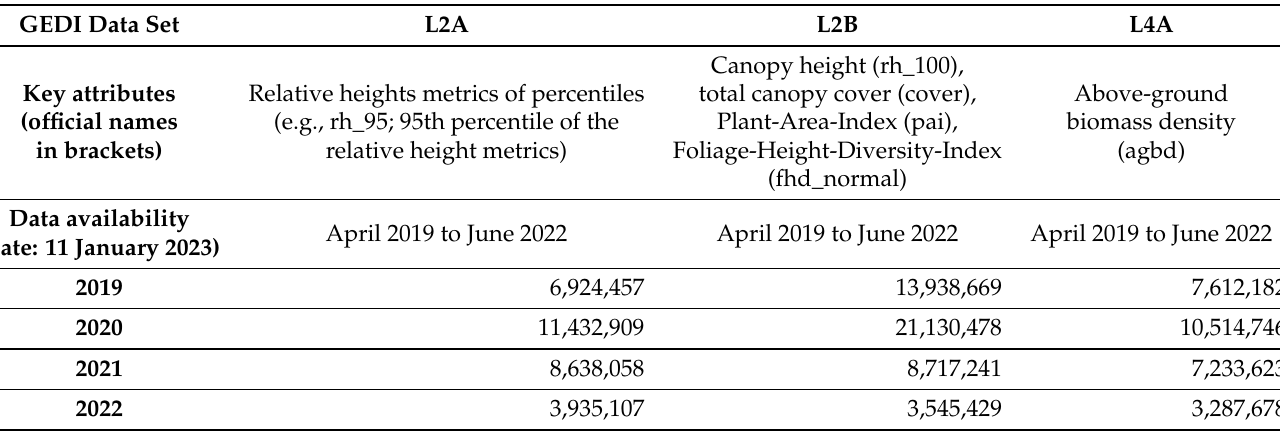
Figure 3. Map depicting a subset (50,000 samples for improved visualization) of quality filtered GEDI L2A canopy height data (rh_95) from 2021 (June to incl. August) for Germany over all land cover types. Since GEDI is attached to the ISS, data acquisition is limited to the northern latitudinal orbit maximum of about 52°N. GEDI measures forest structure in 25 m footprints producing eight transect beams with about 600 m distance in across-track direction and about 60 m distance between footprints in along-track direction ( a , b ) [38]. Table 1. Statistics of quality filtered GEDI data for Germany according to the Algorithm Theoretical Basis Documents (ATBD)